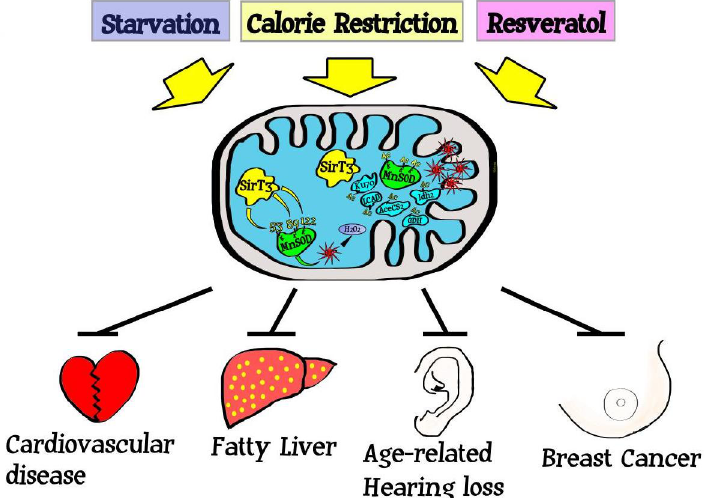
Figure 1. Proposed model describing Sirt3 acetylation and subsequent regulation of downstream target proteins enzymatic activity. Sirt3 is localized into the inner mitochondrial membrane and appears to be activated by agents that induce oxidative stress and respond to aberrant or increased mitochondrial levels of superoxide. Sirt3 has been shown to regulate the activity of other mitochondrial proteins including acetyl-CoA synthetase [63,84], glutamate dehydrogenase (GDH) [84,85], long-chain acyl-CoA dehydrogenase (LCAD) [46], succinate dehydrogenase [86,87], and mitochondrial ribosome subunit MRPL10 [87,88]. Sirt3 has also be shown to have pro-apoptotic or anti-apoptotic effects on different cell types and at least on mechanism involves deacetylating Ku70 and consequently preventing the release of BAX into mitochondria